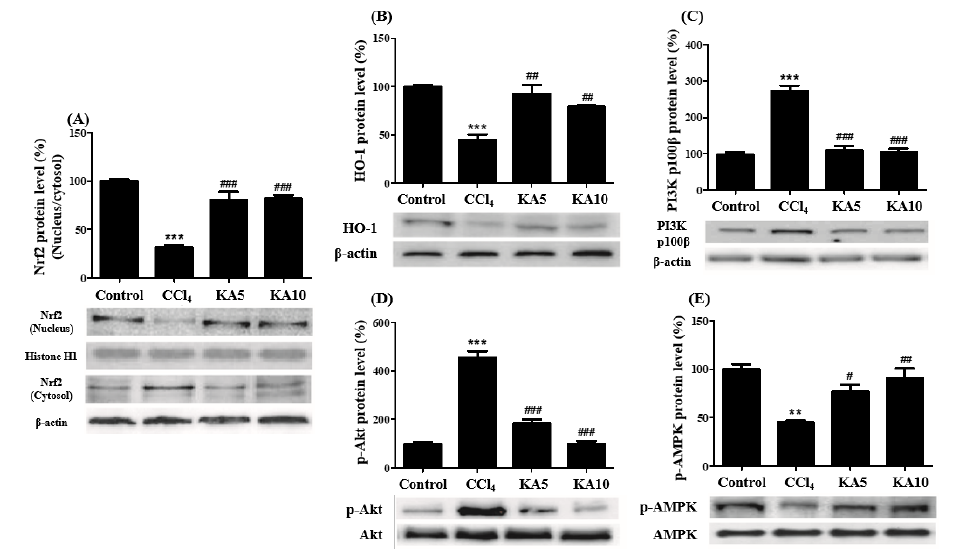
Figure 8. Effects of kaempferol on Nrf2 activation ( A ), HO-1 production ( B ), and PI3K level ( C ), and phosphorylated Akt ( D ) and AMPK ( E ) in CCl 4 -intoxicated rat liver. Western blotting was performed to detect these protein levels and quantified by image analysis. Histone H1, β -actin, total Akt, and AMPK were used as loading controls. Values are mean ± SE ( n = 3). ** p < 0.01 and *** p < 0.001 vs. the control group and # p < 0.05, ## p < 0.01, and ### p < 0.001 vs. the CCl 4 group.